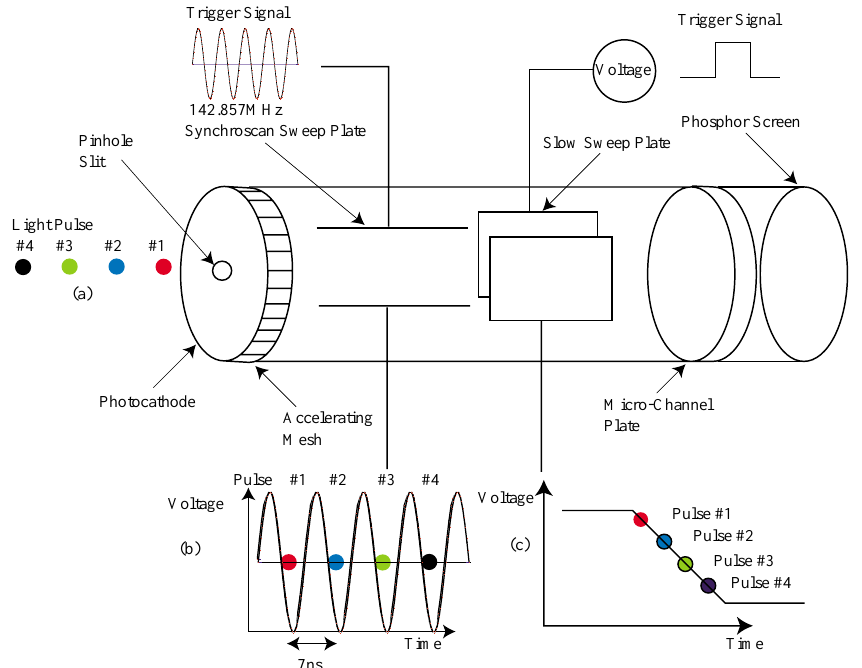
FIG. 5. (Color) (a) The four light pulses that enter the streak camera are separated in time, (b) the four sets of photoelectrons arriving on the zero crossing of the oscillating voltage, and (c) the four pulses arriving on the slow sweep voltage where each photoelectron is deflected at a different angle dependent on its arrival